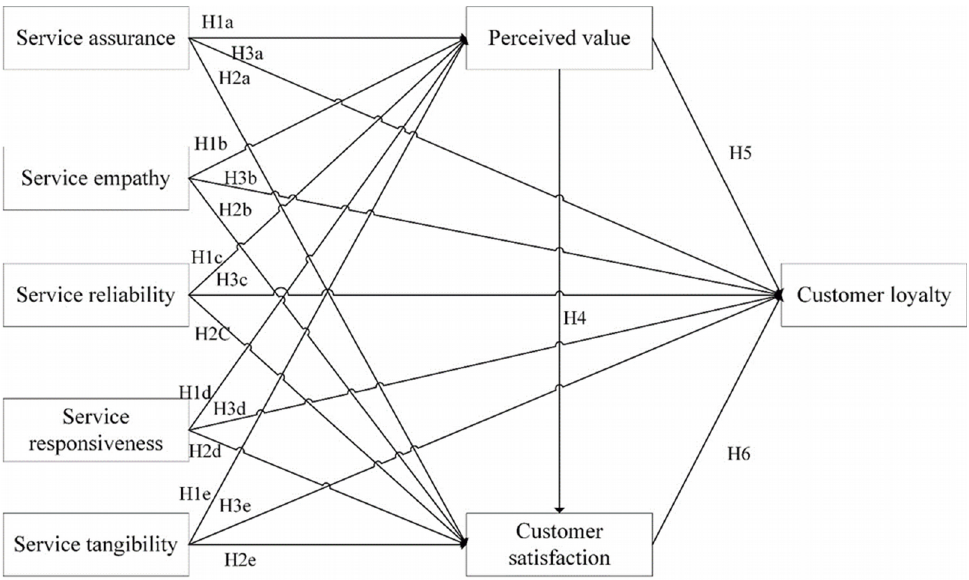
Figure 1. Theoretical model and